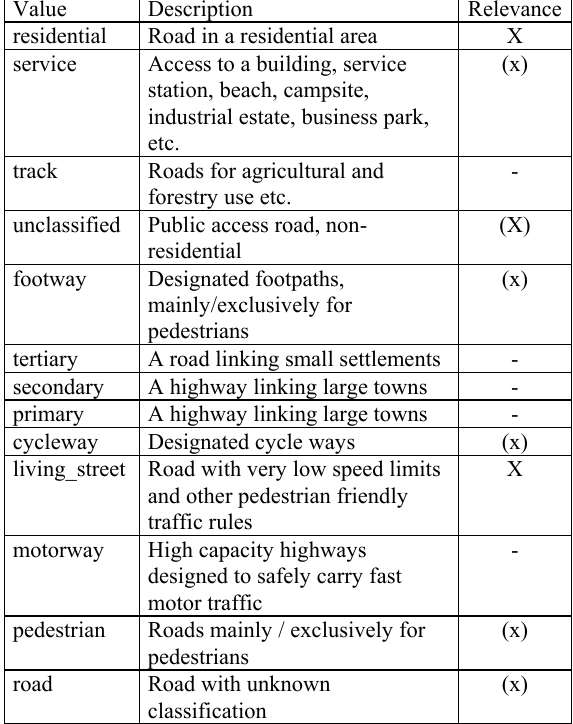
Table 2. Selected, often used values for the “highway” key (entries are ordered by usage starting with the most often